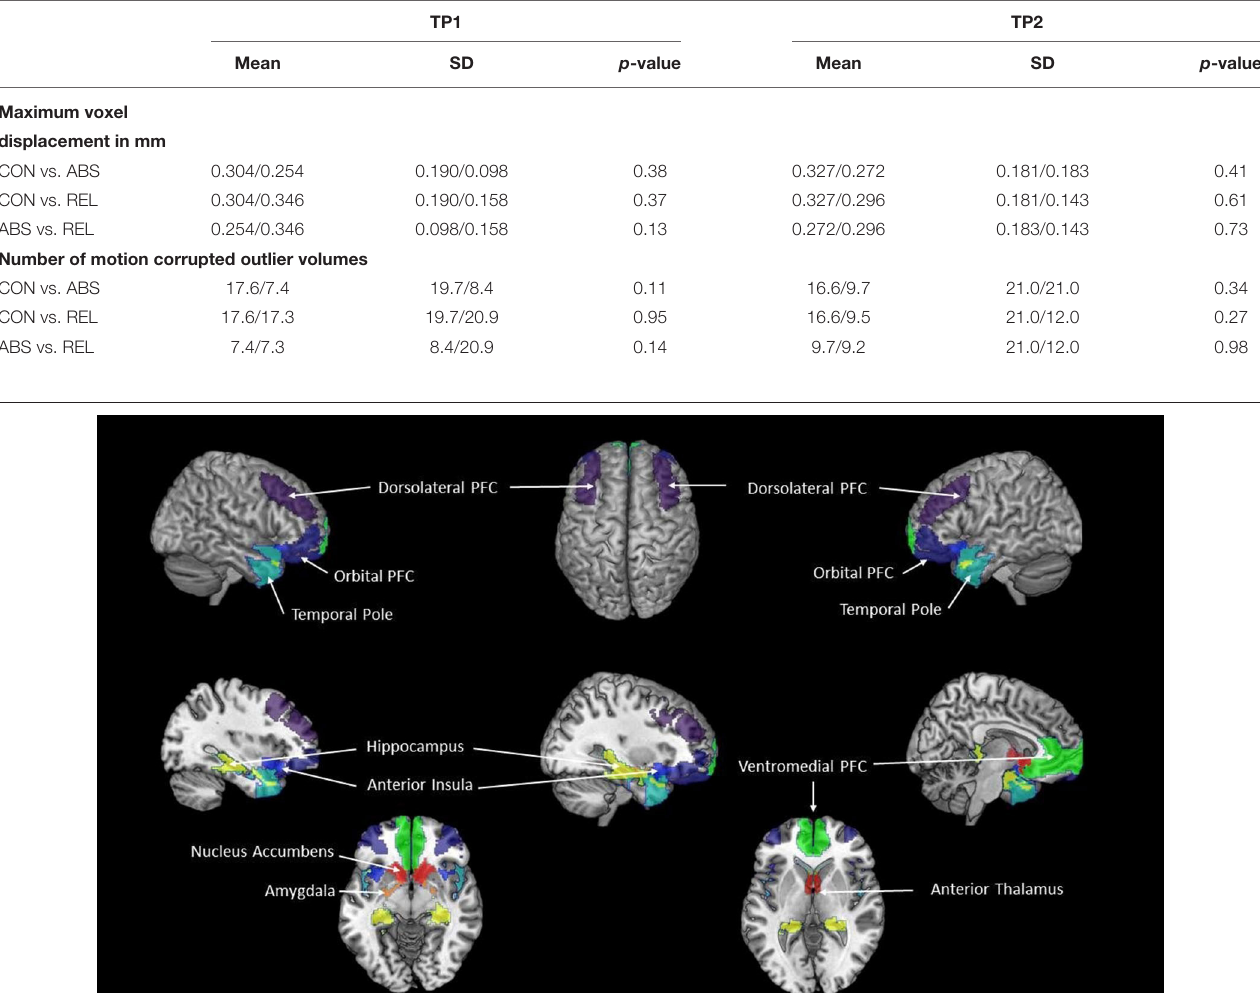
TABLE 2 | Results of the Student t -Tests for Group-Specific Differences in Motion Artifacts and other Physiological Confounds.